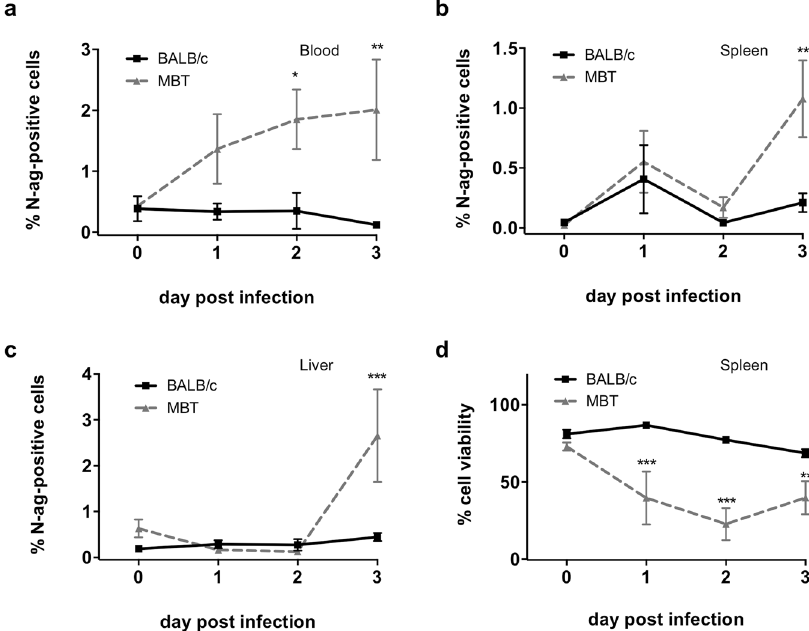
Figure 3. Higher viral antigen load correlates with higher cell death in the spleen of MBT mice. ( a – c) Flow cytometric analysis for the N viral nucleoprotein (N-antigen, N-ag) within the blood ( a ), spleen ( b ), and liver ( c ) cells from BALB/c (n = 5/day) and MBT (n = 5/day) mice on days 1–3 post RVFV infection. (d) Percentages of viable cells in the spleen of RVFV-infected BALB/c and MBT mice using flow cytometry (n = 5 mice/strain/ timepoint). Data are represented as mean ± SEM. Two-way ANOVA was used to test differences between means. * P < 0.05, ** P < 0.01, *** P <